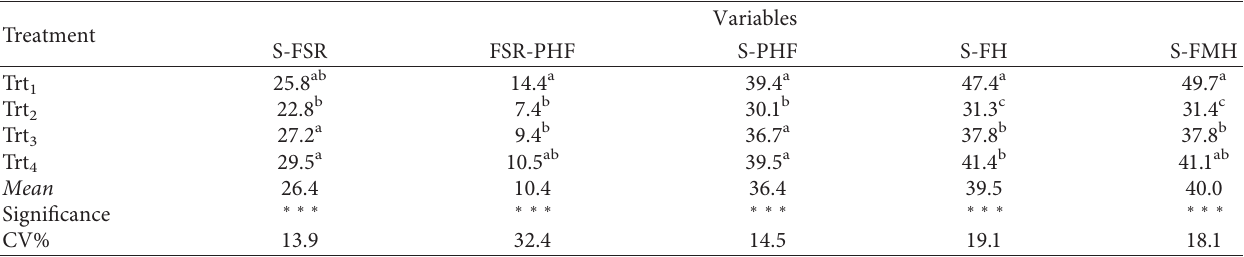
Table 1: Number of days taken for the developmental stages in baobab fruits shells, wheat straw, sawdust, and maize cobs.